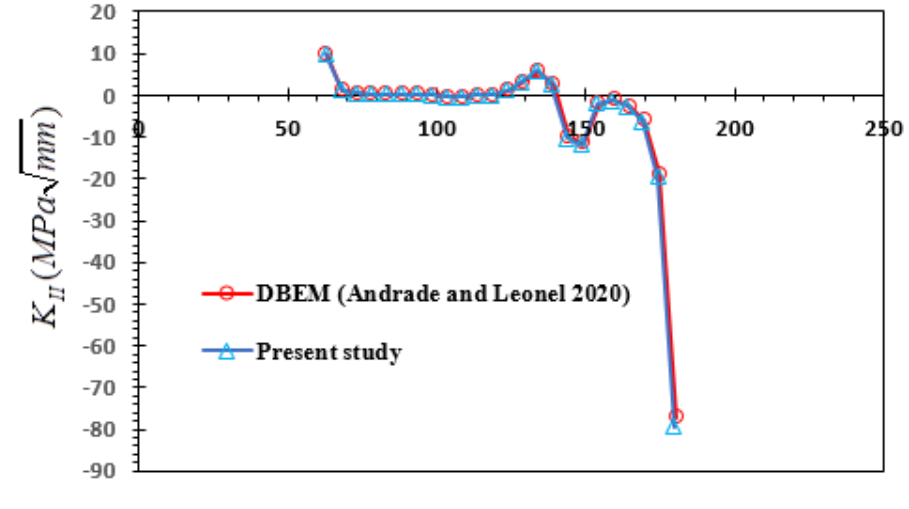
Figure 19. Comparison for the second mode of stress intensity factor ( K II ) for specimen 5.